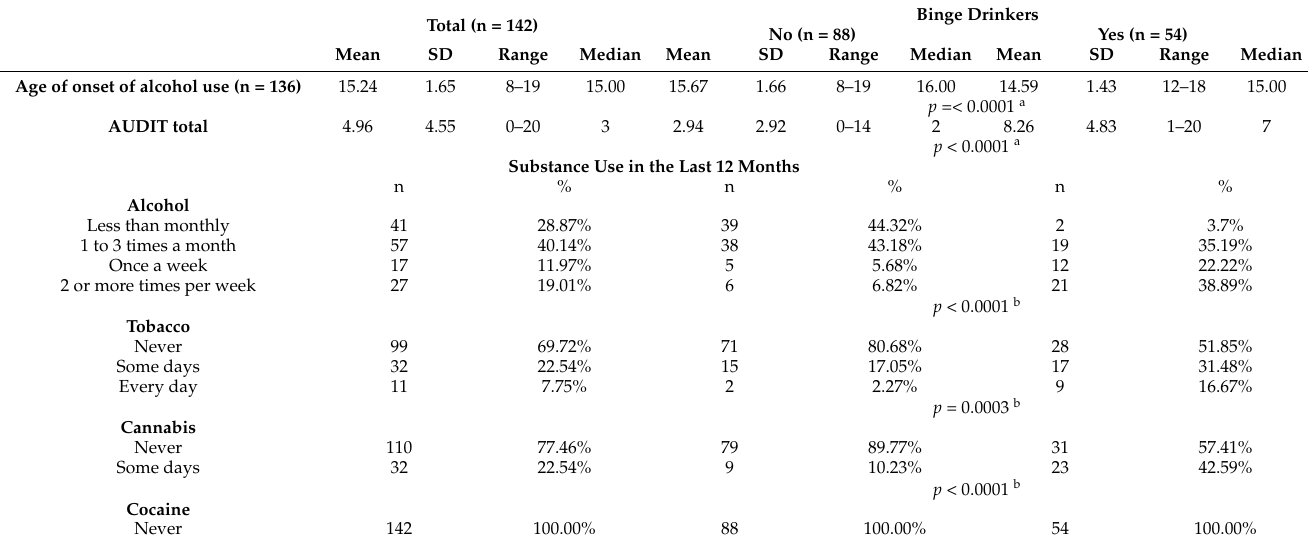
Table 2. Consumption of alcohol and other